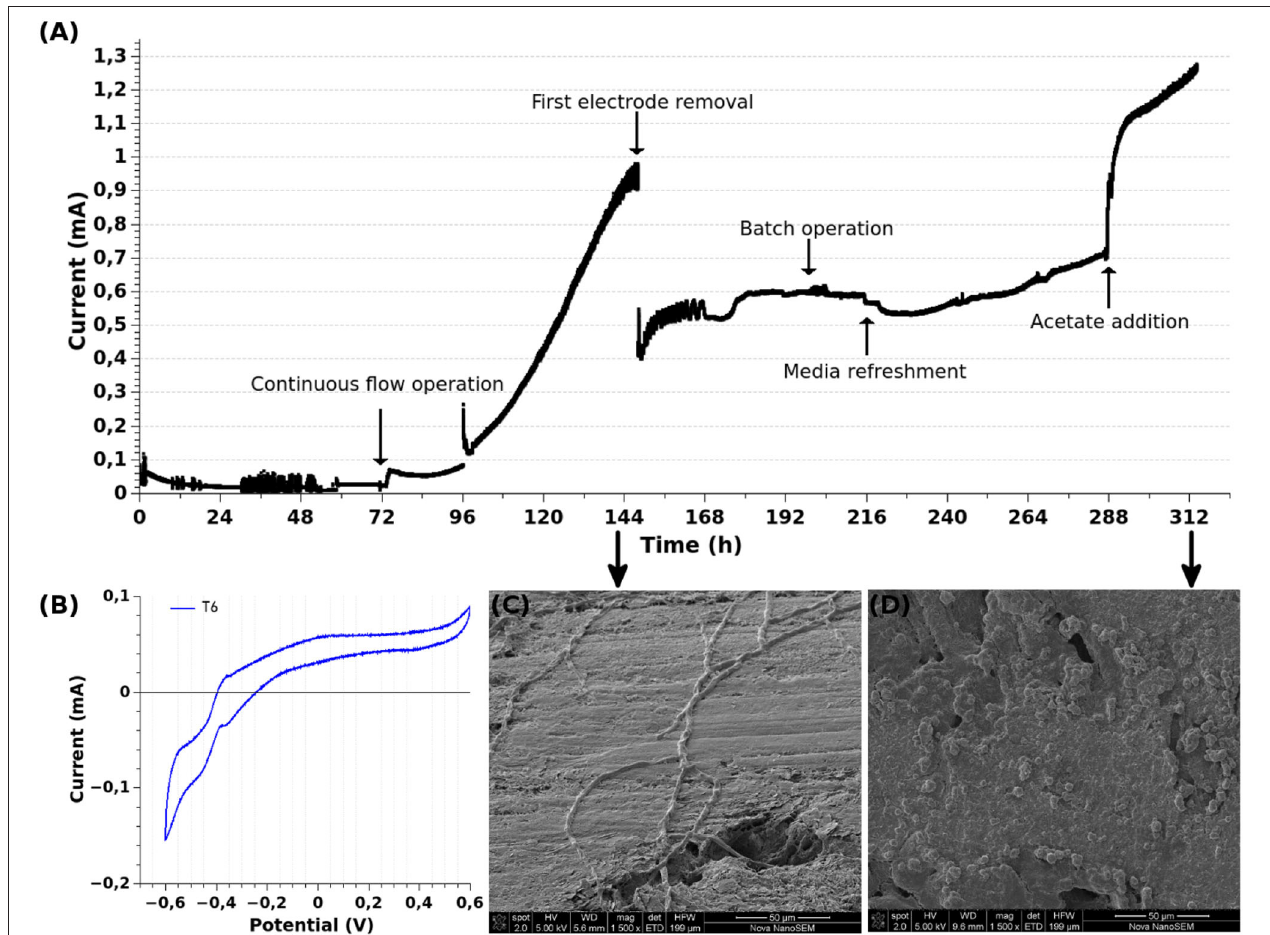
FIGURE 7 | Electrochemical characterization of the selected community. A MEC with two graphite WEs was inoculated with the selected community. The WEs were at an applied potential of 480 mV (vs. Ag/AgCl). The MEC was operated at 30 ◦ C in anaerobiosis, other operational parameters were modified as specified in the figure itself. Continuous flow at a HRT = 24 h. (A) Chronoamperometry. (B) Cyclic voltammetry at 3 mV/s, T6 = 6 days of MEC operation (144 h), potential vs. Ag/AgCl. (C,D) Scanning electron microscopy of the first and second WEs, respectively, removed at the indicated time of MEC